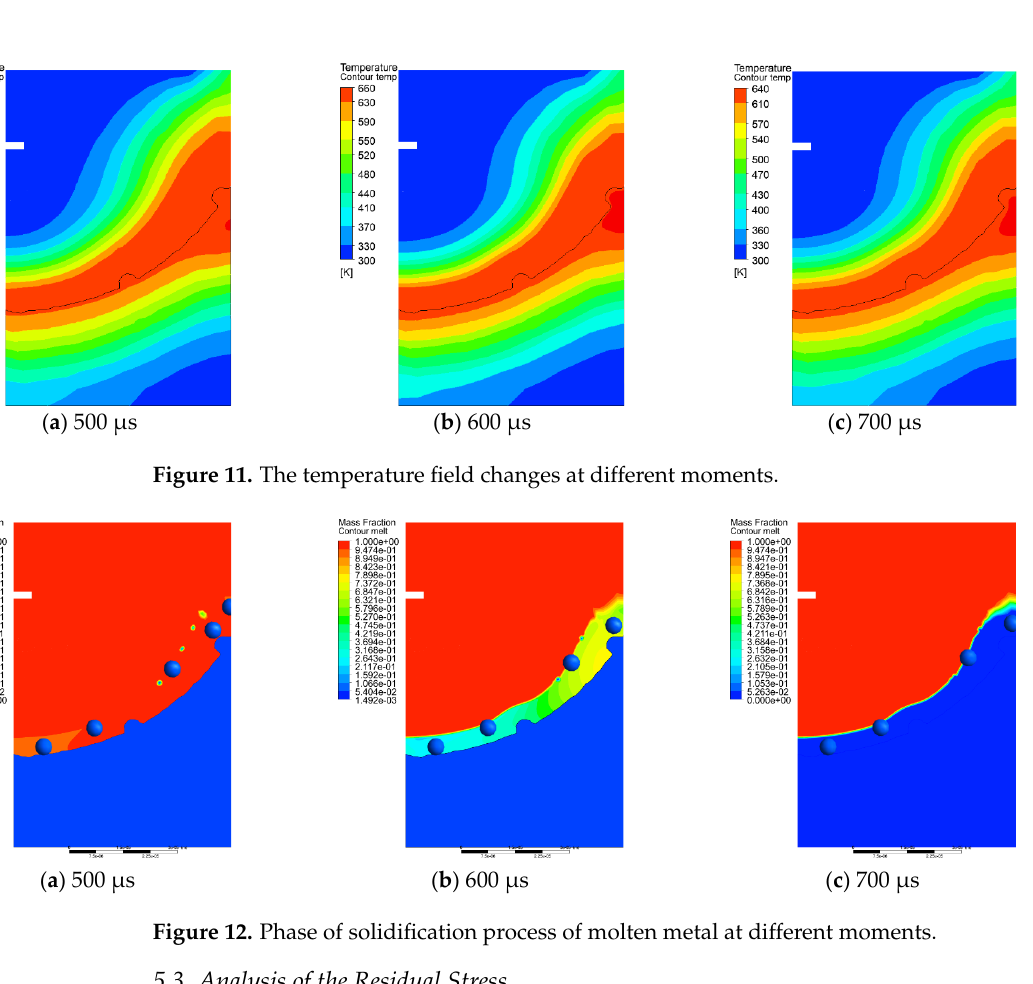
( b ) Figure 14. Experimental process of single pulse tip discharge and its schematic diagram. ( a ) Tip discharge with single pulse; ( b ) Tip discharge process. Table 2. Discharge parameters in EDM machining. Parameter